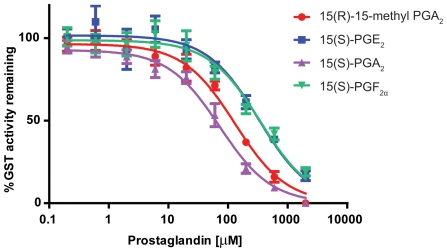
Inhibition of Cyphoma affinity-purified GST activity by select prostaglandins.Points represent the mean (±SE) GST activity remaining compared to solvent controls after incubation with various concentrations (0.2–2000 µM) of 15(R)-15-methyl PGA2 (•), 15(S)-PGE2 (▪), 15(S)-PGA2 (▴), 15(S)-PGF2α (▾). The reaction mixture consisted of 3.3–6.4 ng of affinity-purified GST protein in 0.1 M potassium phosphate buffer, pH 7.5, containing 1 mM GSH, 1 mM CDNB at 25°C with 5% (v/v) DMSO. Affinity-purified GST preparations from five snails were used as the enzyme source with specific activities of ranging from 290–582 µmol min−1 mg protein−1. Plots were used to obtain the IC50 value for each prostaglandin and are listed in Table 1.